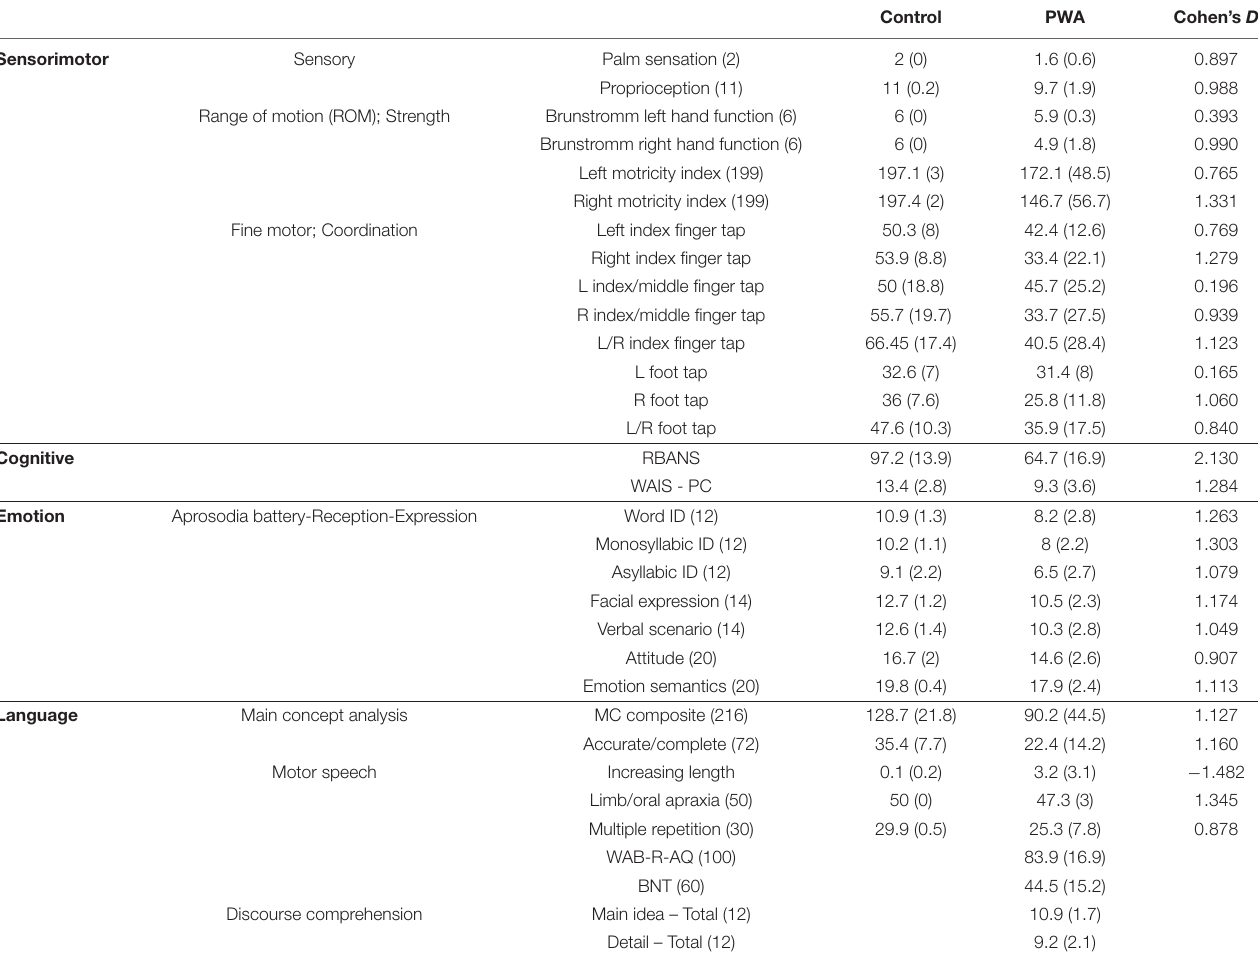
TABLE 2 | Test scores for healthy controls and persons with aphasia included in the analysis as well as Cohen’s D effect sizes to estimate the magnitude of the difference between groups.